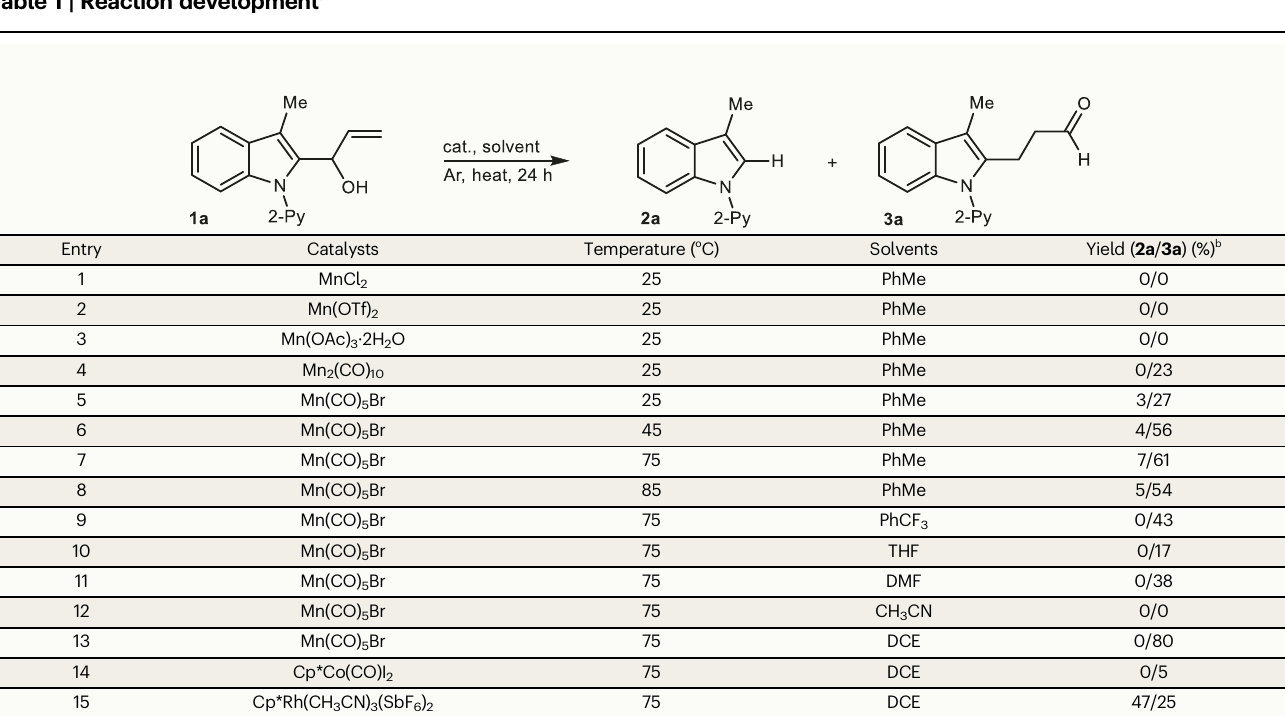
Table 1 | Reaction development